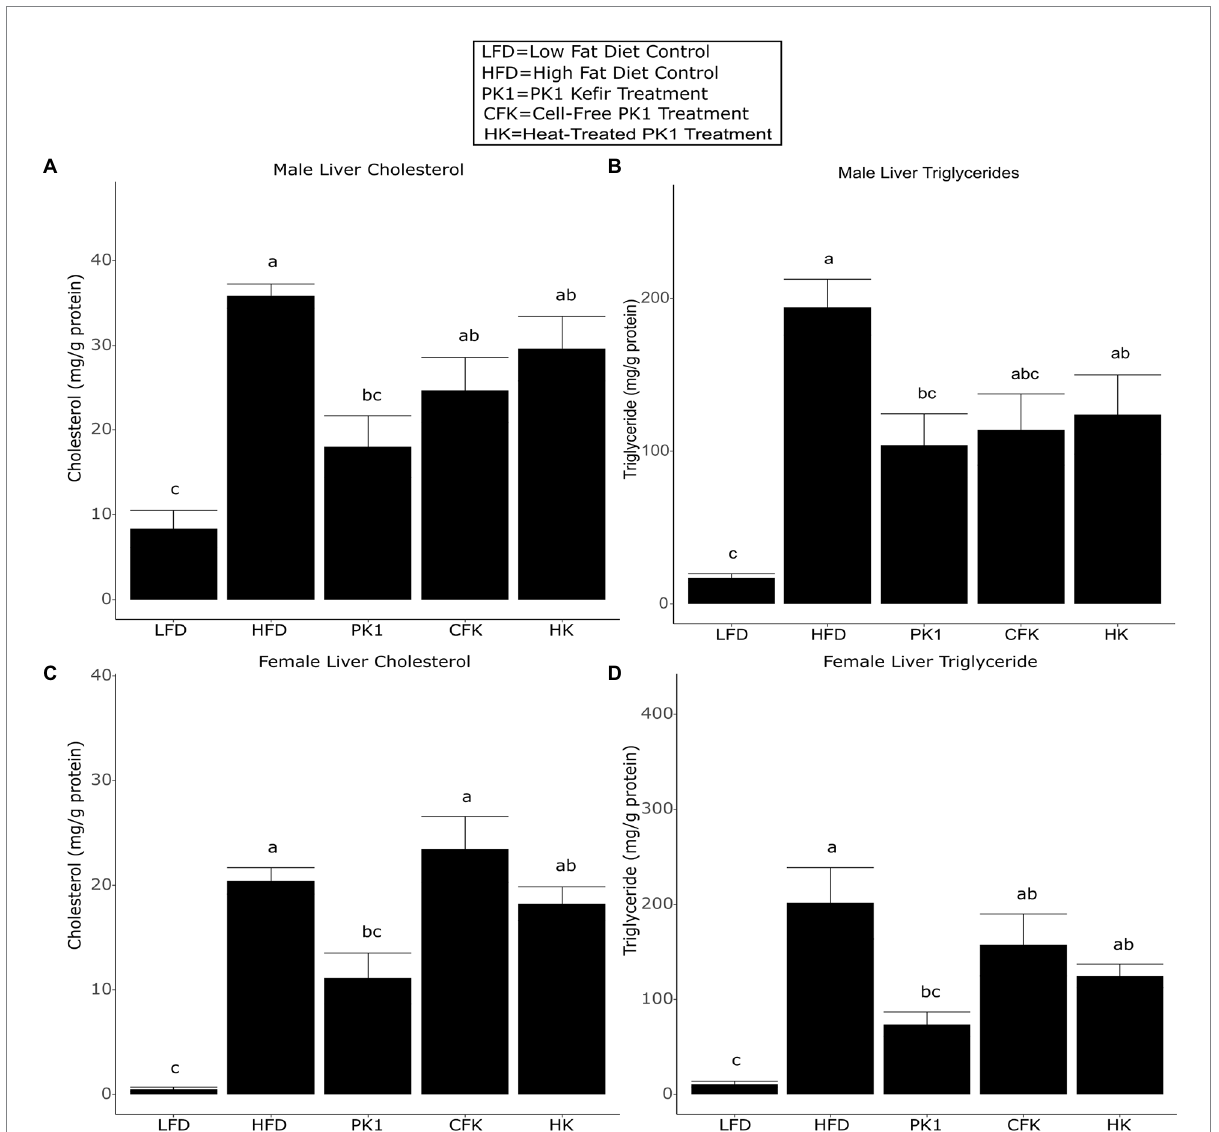
FIGURE 3 Concentration of liver cholesterol (A,C) and triglycerides (B,D) in male/female C57Bl/6 mice fed a control diet or high-fat diet supplemented with milk or different kefir preparations for 8 weeks. Data are expressed as mean values with their standard errors ( n = 7–8). Means that do not share a letter are significantly different ( p < 0.05). LFD, mice fed a low fat diet supplemented with freeze-dried milk for 8 weeks; HFD, mice fed a high fat diet supplemented with freeze-dried milk for 8 weeks; PK1, mice fed a high fat diet supplemented with freeze-dried pitched kefir for 8 weeks; CFK, mice fed a high-fat diet supplemented with freeze-dried cell-free kefir; HK, mice fed a high-fat diet supplemented freeze-dried heat-treated